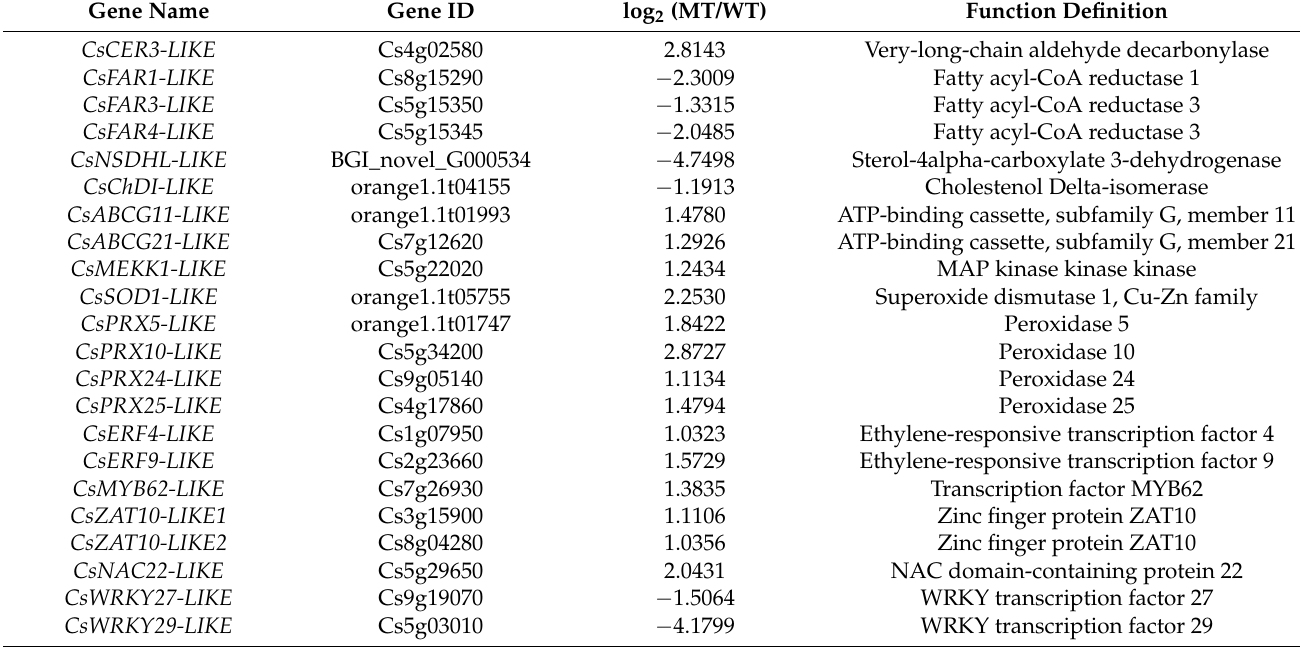
Table 1. The differentially expressed genes involved in wax biosynthesis and transport, MAPK cascade, ROS scavenging and encoded drought-responsive transcription